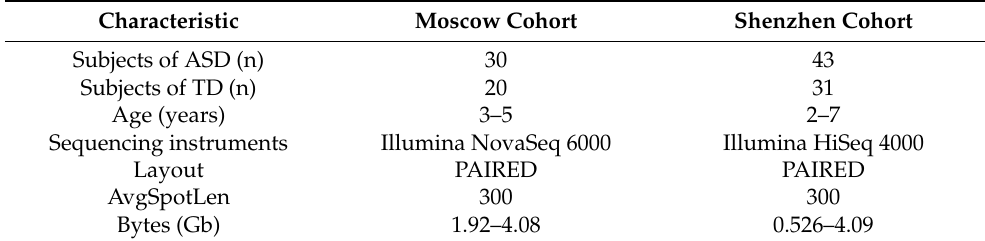
Table 2. Description of sample